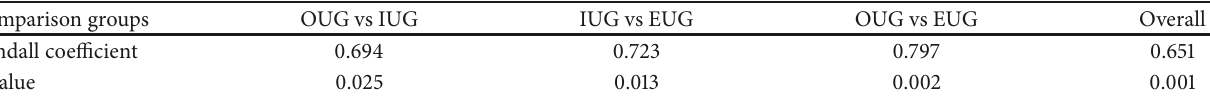
Table 6: Kendall coefficient